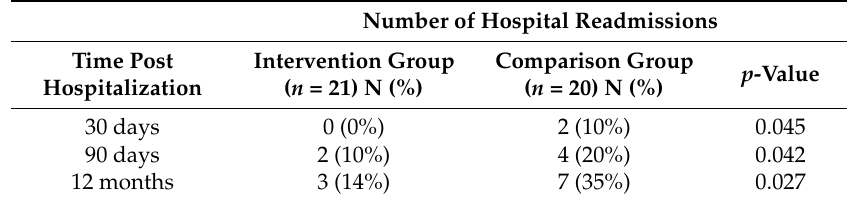
Table 4. Number of Hospital Readmissions